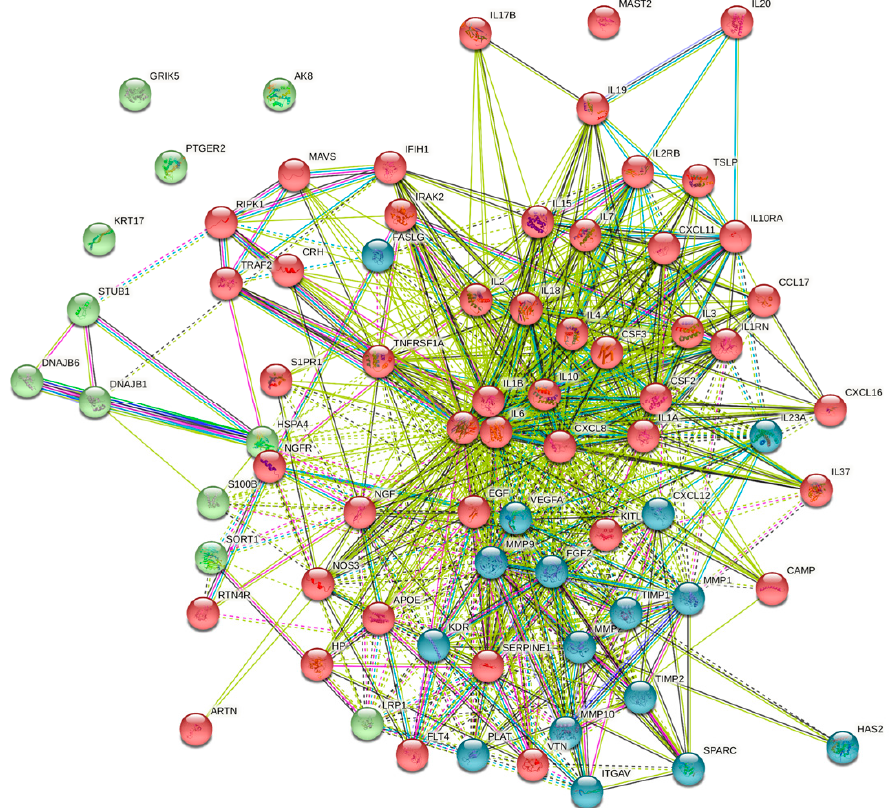
Figure 4. Clustering of the studied proteins shows three distinct clusters, with the growth factors on the border between the first and second clusters.